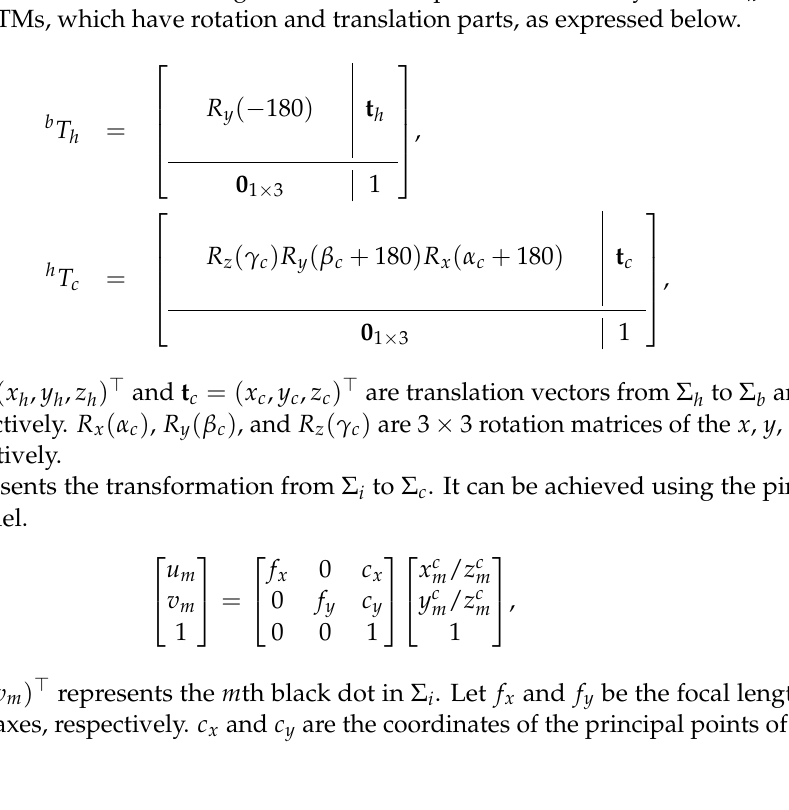
Figure 4. Coordinate systems. Red, green, and blue arrows represent x , y , and z axes, respectively. DENSO VP-6242 robot [20] is used.